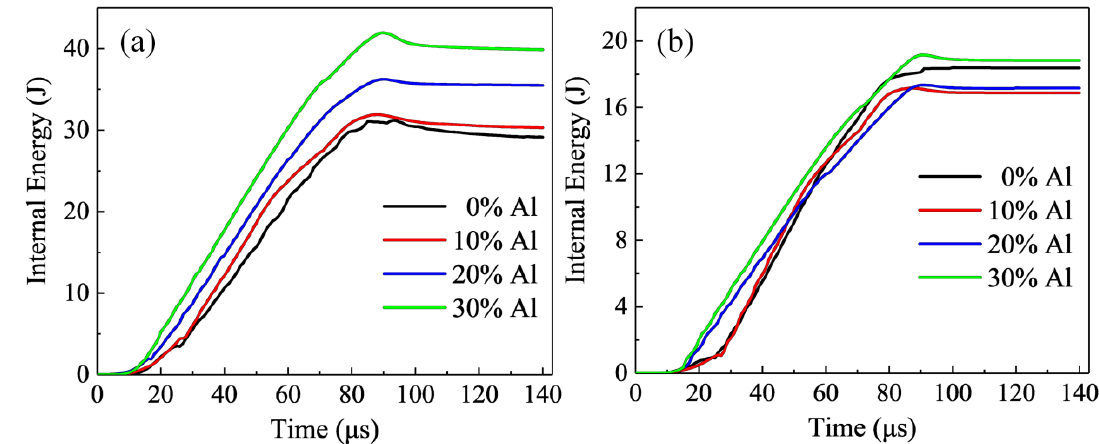
Figure 6. Energy absorption–time curves of Ti–Al3Ti–Al laminated composites with different Al contents: ( a ) the whole; ( b ) Ti layers.